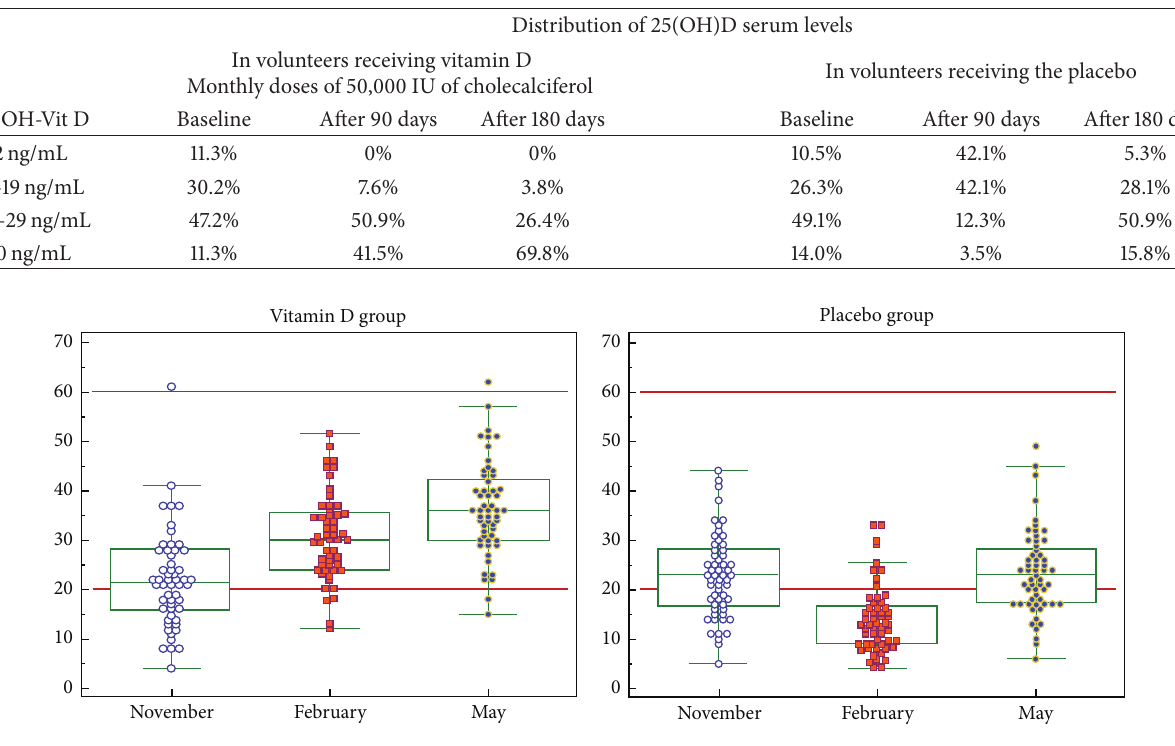
Figure 1: Serum 25(OH)D (ng/mL) levels observed in a young healthy population after 3 (February) and 6 (May) months of supplementation with a monthly dose of 50,000 IU of cholecalciferol or a